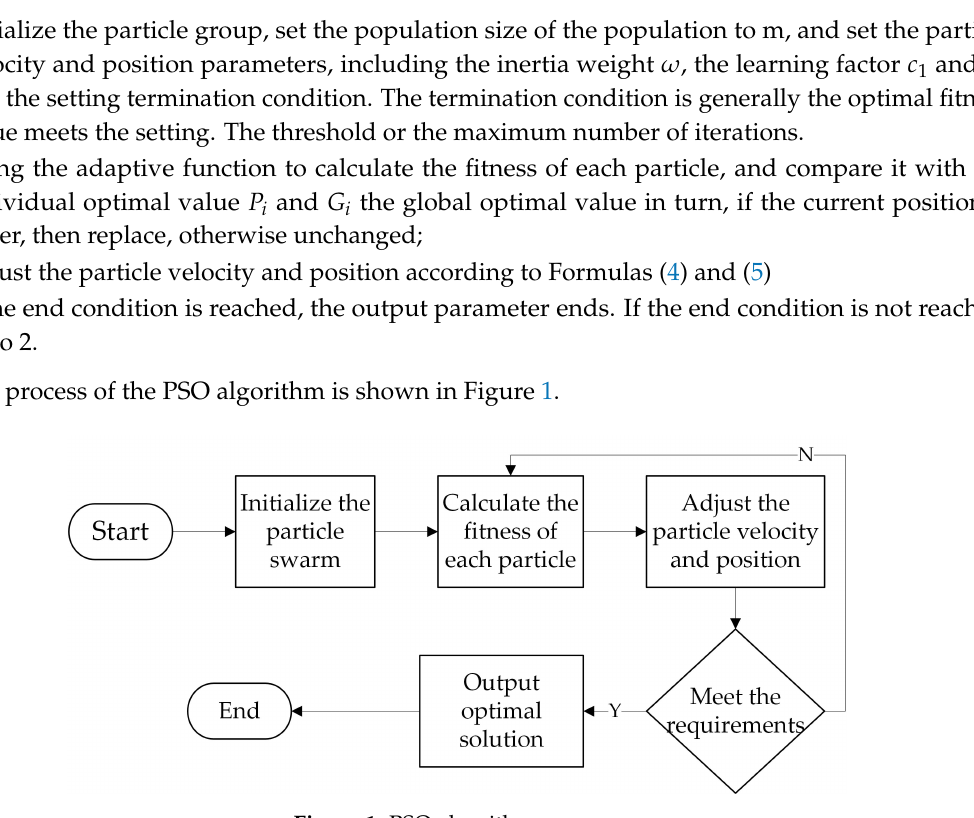
Figure 1. PSO algorithm